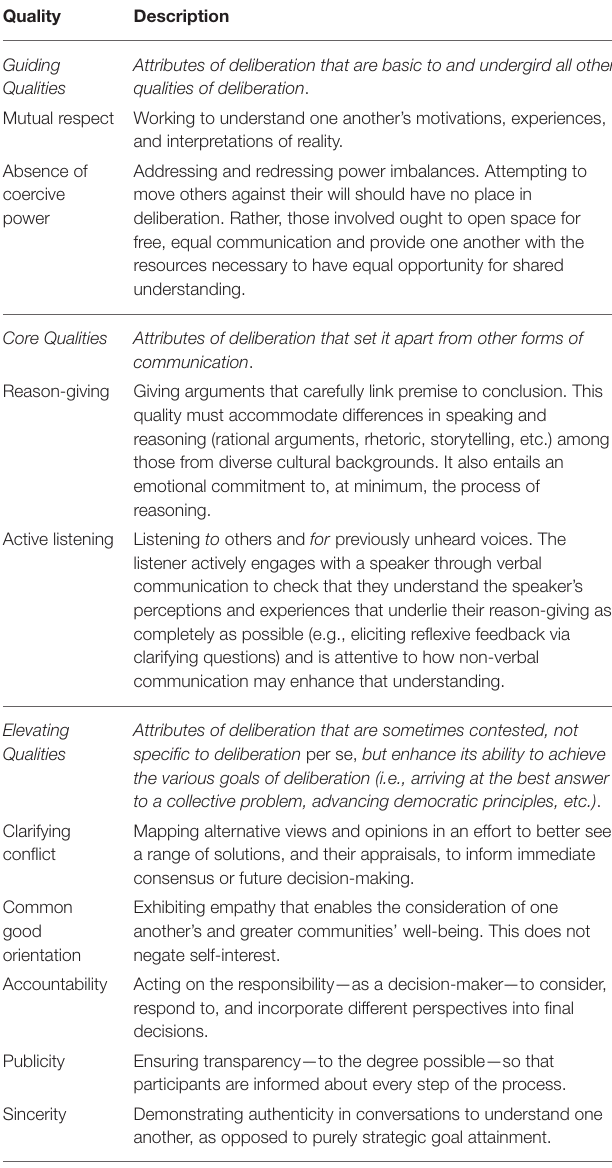
TABLE 1 | Qualities of good deliberative